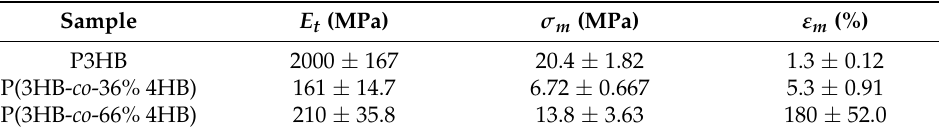
Table 3. Results from the tensile tests.